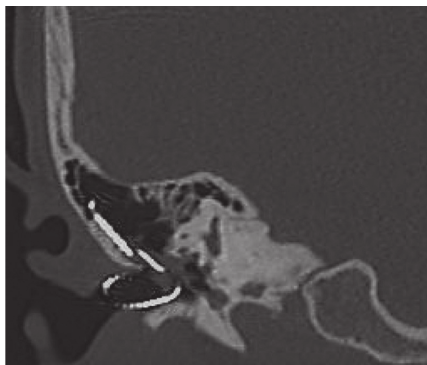
Figure 2: Coronal CT scan of the right temporal bone confirming explantation had taken place with the electrode array coiled up in the external auditory